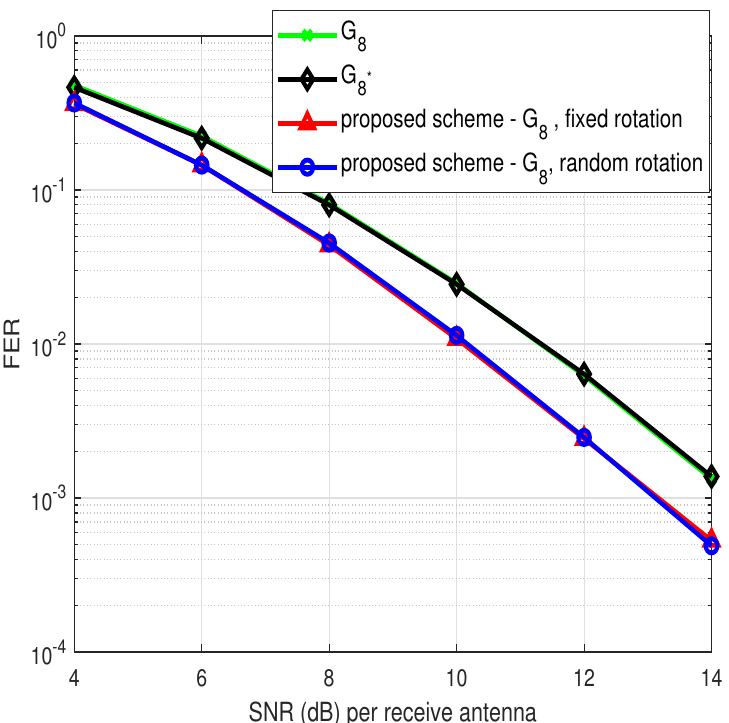
Figure 7. Performance of the proposed scheme based on BPSK − modulated STTC, M T = 2, M R = 1, L = M = 2.